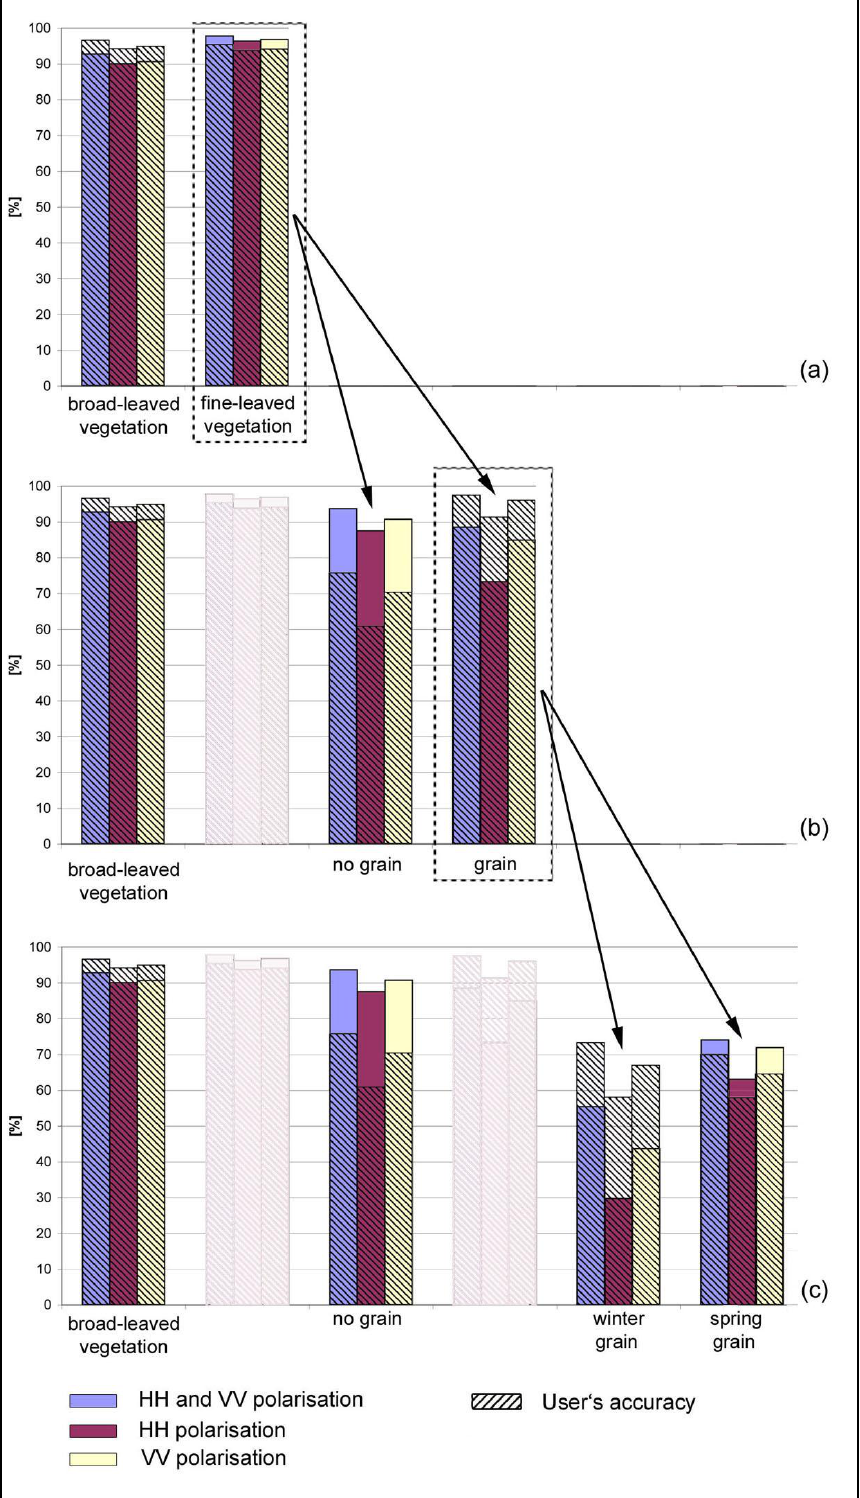
Figure 8. Classification accuracies for class groups in the Fuhrberg study area (a) Overall accuracy for HH + VV polarization is 95.87% (Kappa coefficient is 0.92). For HH polarization values are 93.89% (0.89) and for VV polarization 94.41% (0.89). (b) HH + VV: 91.36% (0.88), HH: 82.99% (0.78), VV 88.46% (0.89) (c) HH + VV: 82.06% (0.77), HH: 72.5% (0.66), VV: 77.89%